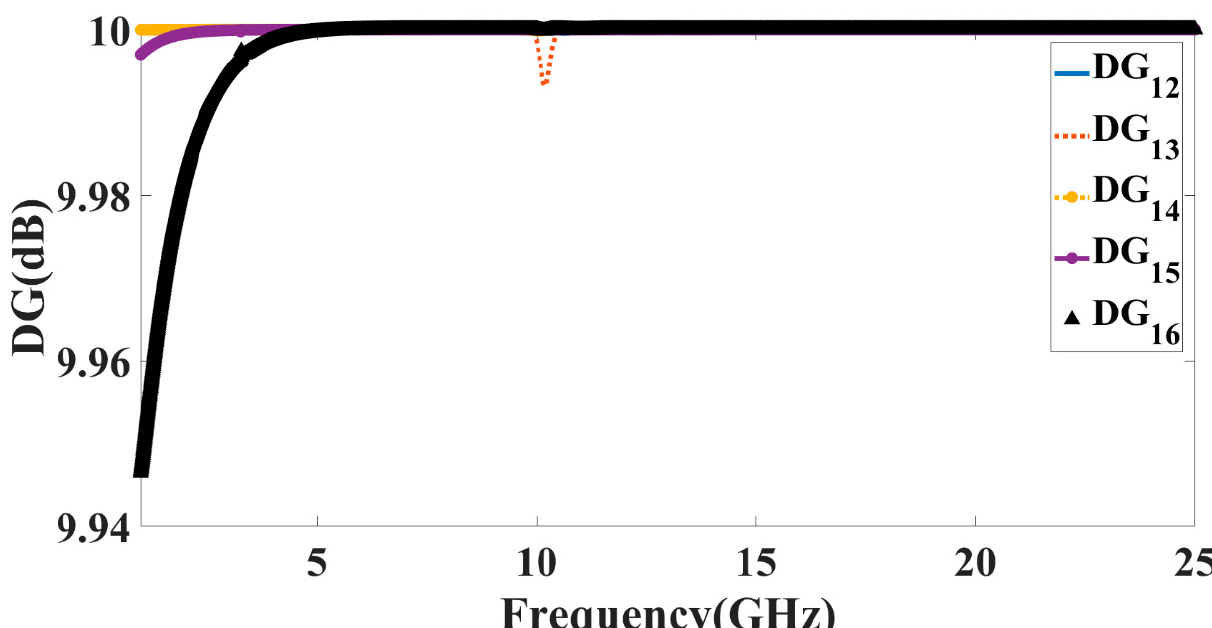
Figure 13. Calculated values of the DG for antenna Design 5.